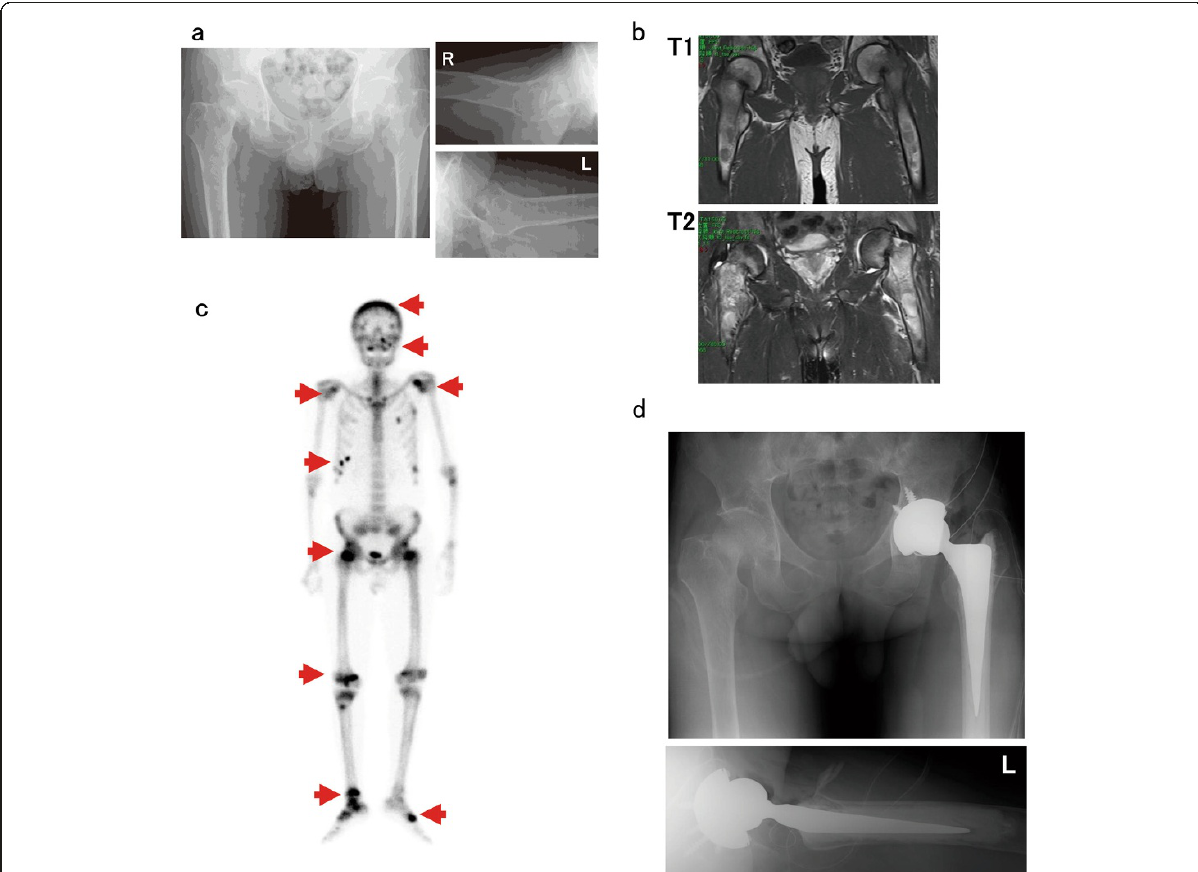
Figure 1 Imaging studies. a : Plain radiographs of both femurs reveal femoral neck fractures. (right, Garden III fracture; left, Garden IV fracture) b : Coronal T1-weighted image demonstrates low-intensity femoral neck fractures and the T2-weighted image shows high-intensity bone edema. c : 99m Tc-hydroxymethylene diphosphonate (HMDP) scintigraphy demonstrates significant abnormal uptake in calvaria, maxilla, both scapulae, ribs, both femoral necks, right condyle of the femur, right tibia, and both tarsi. d : Plain radiographs of hip joints in which total hip arthroplasty was performed by inserting an implant in the left hip